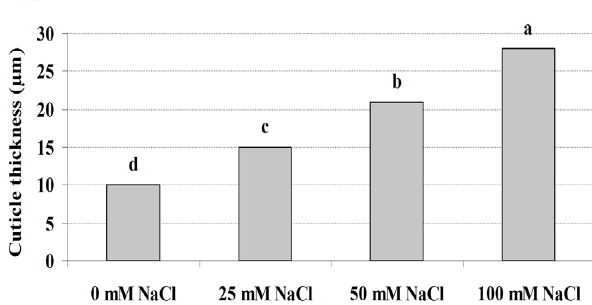
Fig. 4. Changes in stem xylem thickness affected by different salinity stress. Within each column followed by the same letter are not significantly differences (p <